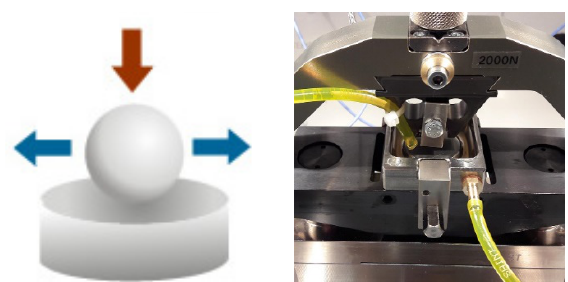
Figure 3. The tribosystem (left) and the specimens assembled into the tribometer (right) were used for